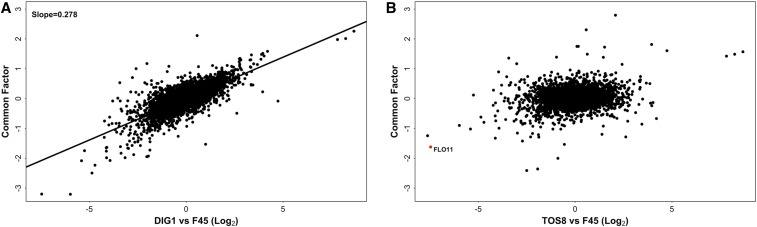
(A) DIG1 overexpression profile (relative to F45) vs. the common factor, with linear regression line and slope. (B) TOS8 overexpression profile (relative to F45) vs. the common factor.